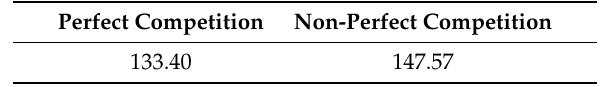
The net income for the Belgium agent in March 2016 for perfect and non-perfect competition